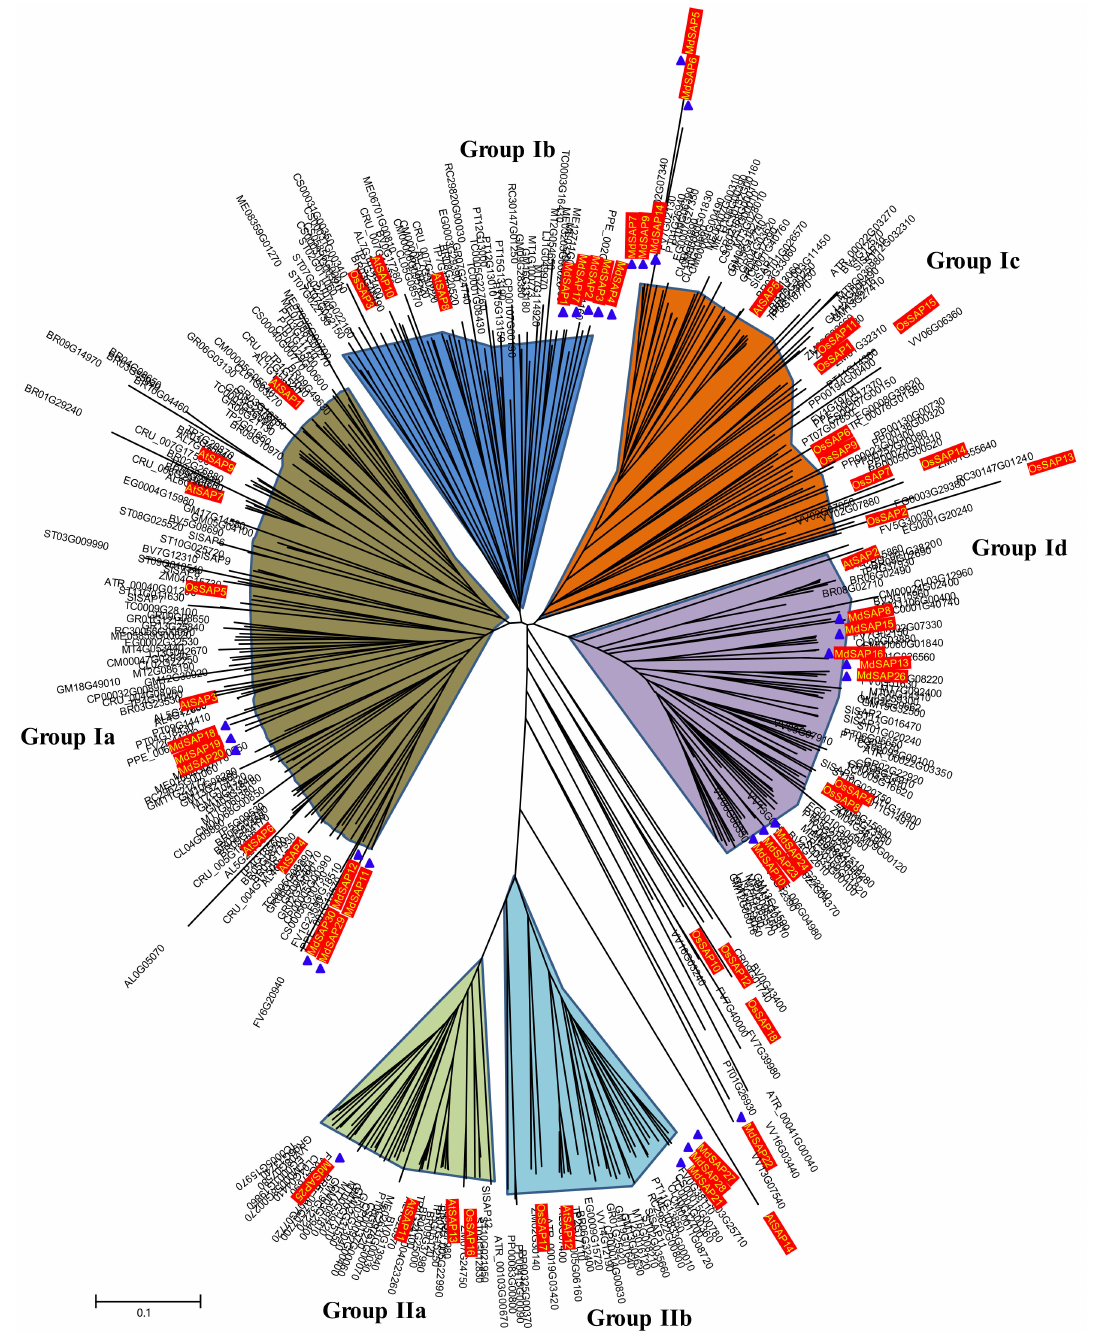
Figure 4. Phylogenetic analysis of 453 SAP proteins in 32 species. Unrooted NJ tree was constructed with MEGA 6 software, using full-length amino acid sequences. Tree comprises six subgroups (Ia–Id; IIa and